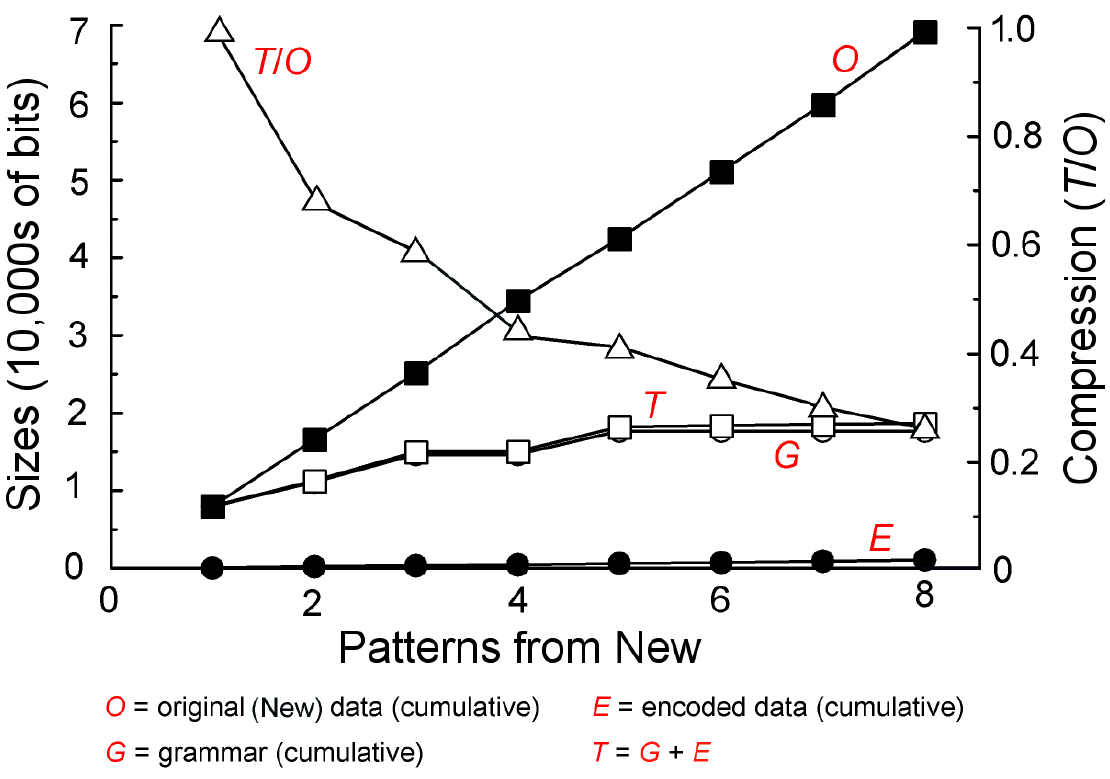
Figure 9. Changing values for G , E and T and related variables as learning proceeds, as described in the